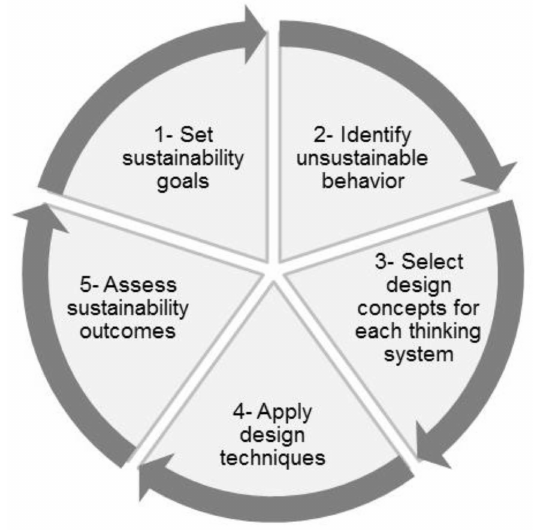
Figure 1. Iterative process of applying the SBD